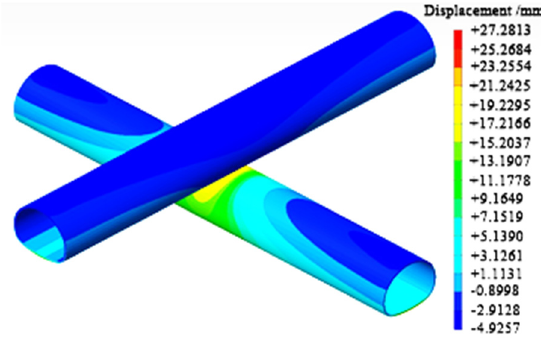
Figure 8. Initial displacement of tunnel lining.